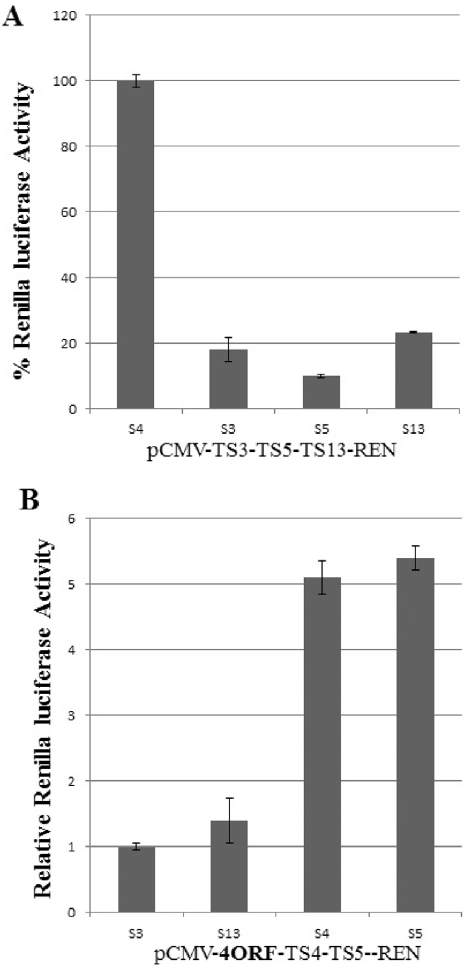
Fig. 5. Induction of a renilla luciferase transgene by siRNA. (A) Three siRNA target sites were placed upstream the renilla luciferase reporter gene, without the UIR, and tested for the known standard siRNA activity. (B) Effects of siRNAs on renilla luciferase reporter gene in a construct containing the 4ORF UIR. In (A) the luciferase activity of the control S4 siRNA was set as 100%. In (B) the luciferase activity of the control S3 siRNA was set as 1 and the luciferase activity values obtained with each of the other siRNAs were compared to that. The experiments were repeated 3 times and each experiment was done in triplicates. Statistical analysis was done by T-test and the bars represent standard error. P Values in A are 2*10( 2 5); 1*10( 2 5); 0.002 for S3, S5 and S15, respectively. P Values in B are 0.0008; 1*10( 2 6) for S3 and S5, respectively.